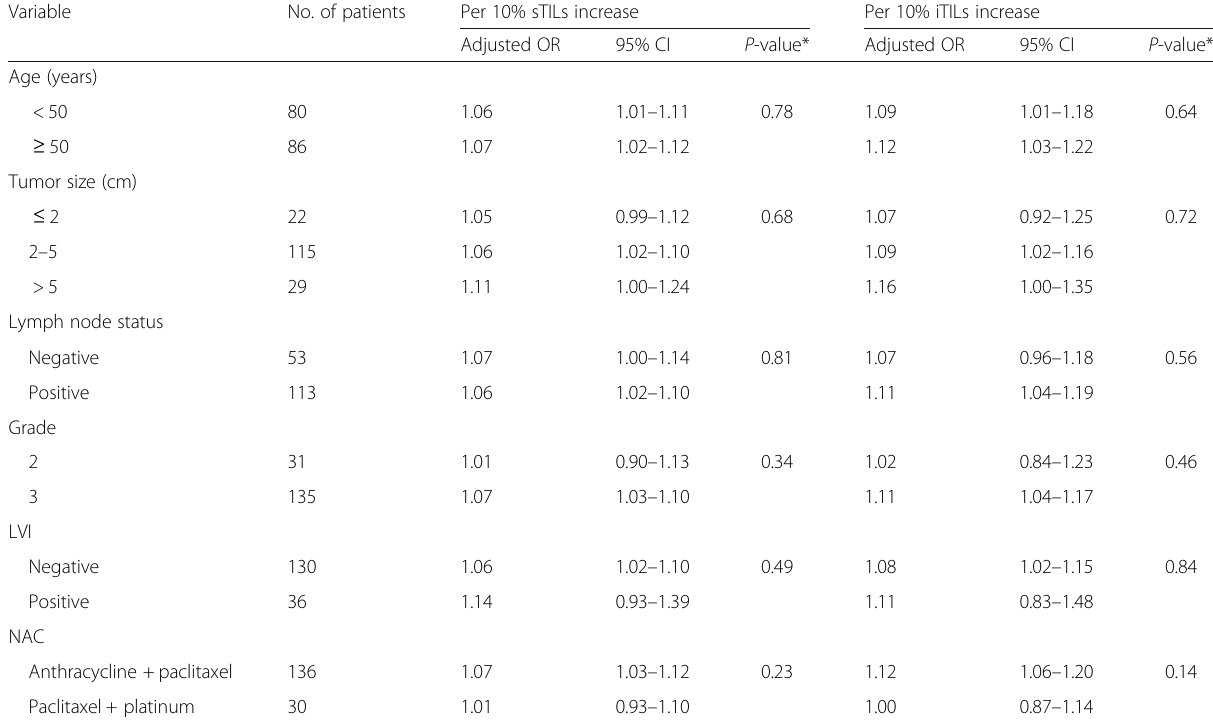
Table 4 Correlations between TILs and pCR in clinicopathologic subgroups Variable No. of